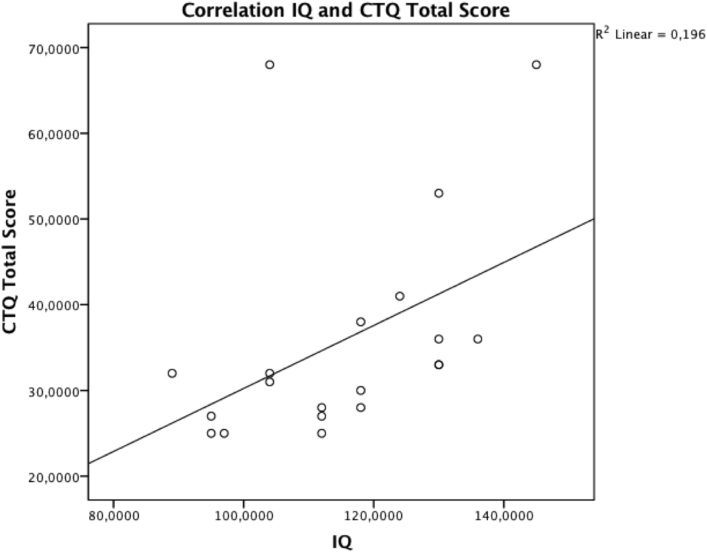
Scatterplot 2: Correlation between IQ and CTQ Total Score.